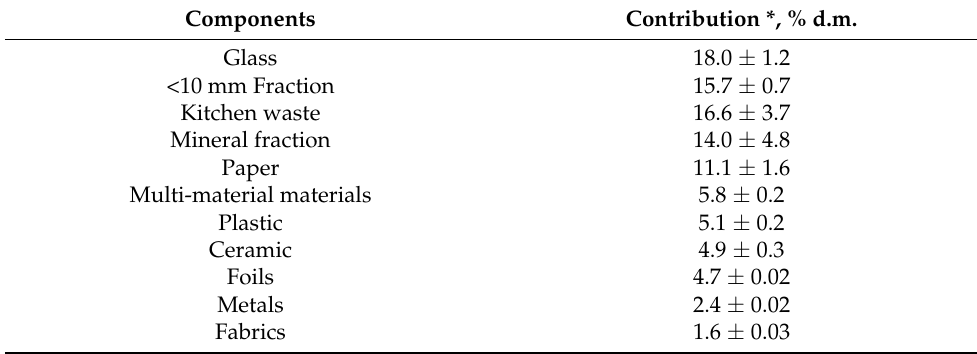
Table 1. The composition of the feedstock (0–80 mm fraction) directed to the reactor [31,32].